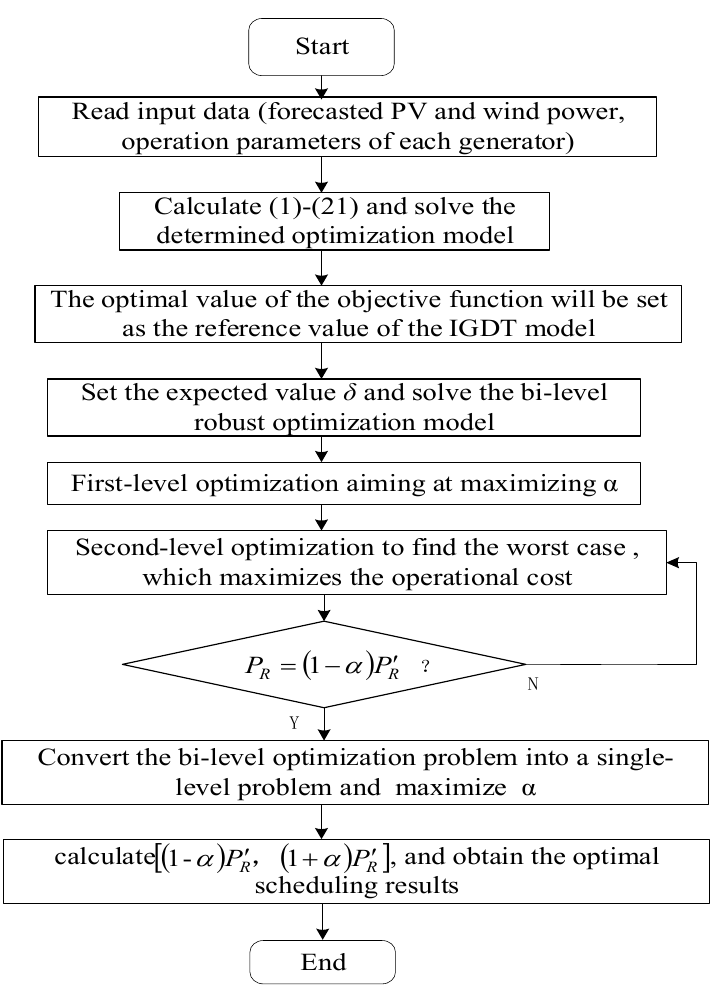
Figure 1. The flow diagram of the proposed information gap decision theory (IGDT)-based spinning reserve optimization model.